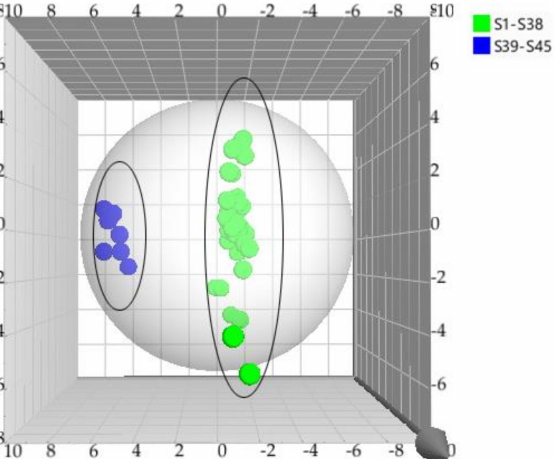
Figure 2. The OPLS–DA model for the classification of TAXH and TOLH based on the content of 33